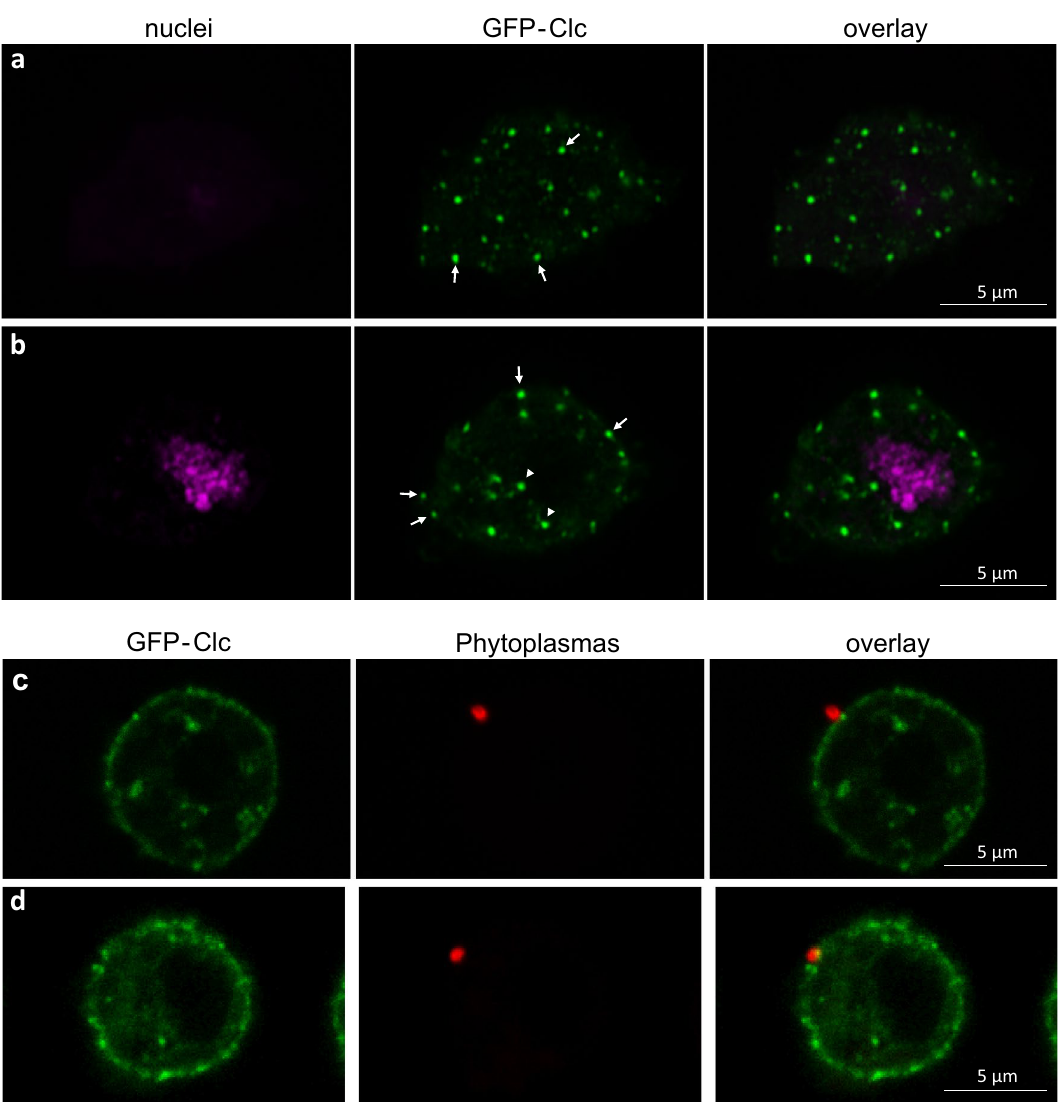
Figure 5. Observation of S2 cells expressing clathrin light chain tagged with GFP (GFP-Clc) and infected with FD phytoplasmas. ( a , b ) S2 cell expressing GFP-Clc and imaged at the surface of the cell ( a ) and inside the cell ( b ). Arrows indicate dots of GFP-Clc at the surface of the cells and arrowheads internal GFP-Clc dots. The nuclei were stained with DAPI and coloured in magenta; the GFP-Clc was coloured in green. ( c , d ),